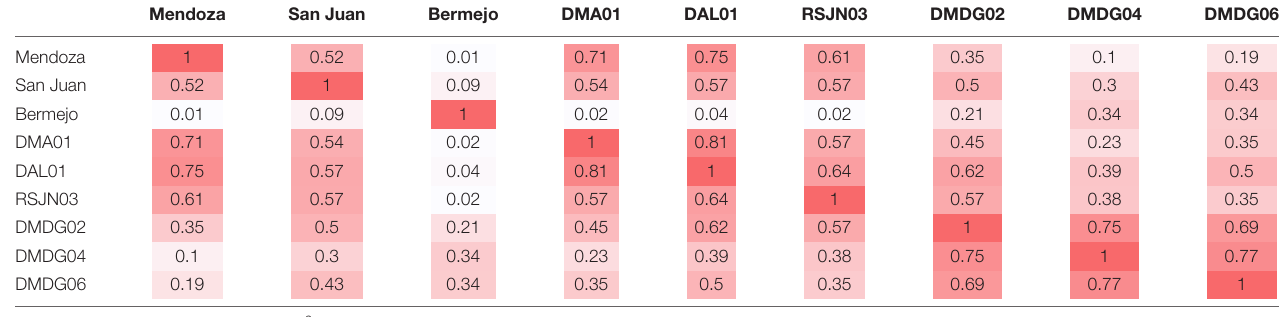
Darker red shading indicates greater R 2 value.